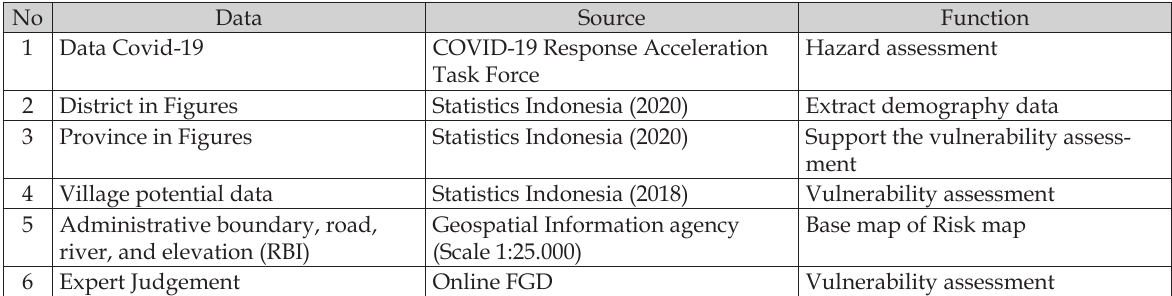
Table 3. The data used in the